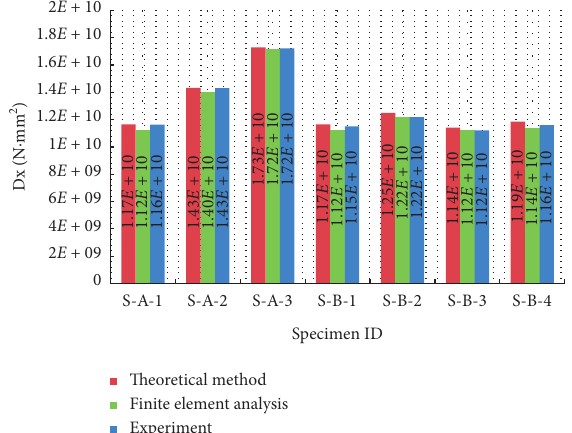
Figure 13: Experimental vs. simulated-theoretical results for bending stiffness.